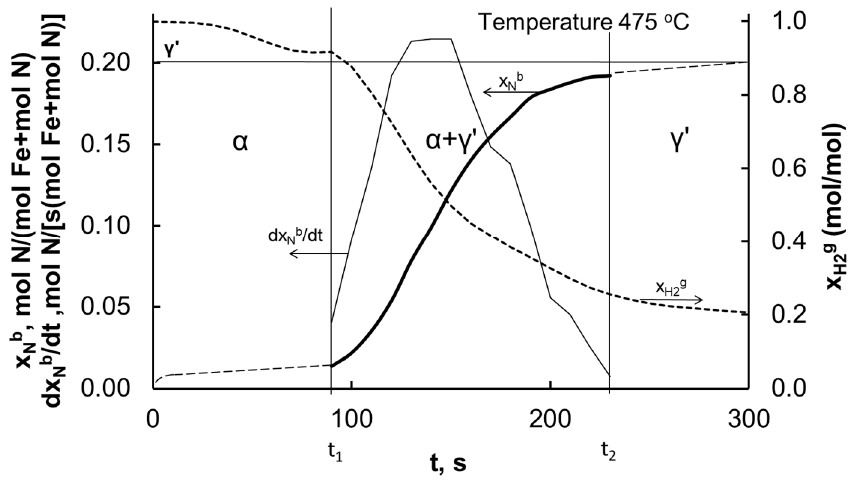
Figure 1. Nitriding degree, nitriding reaction rate, and hydrogen concentration as functions of time in nitriding process.